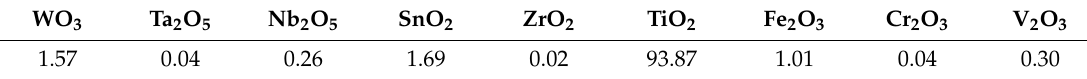
Table 5. Elemental median concentration values (wt %) characterizing rutile grains.